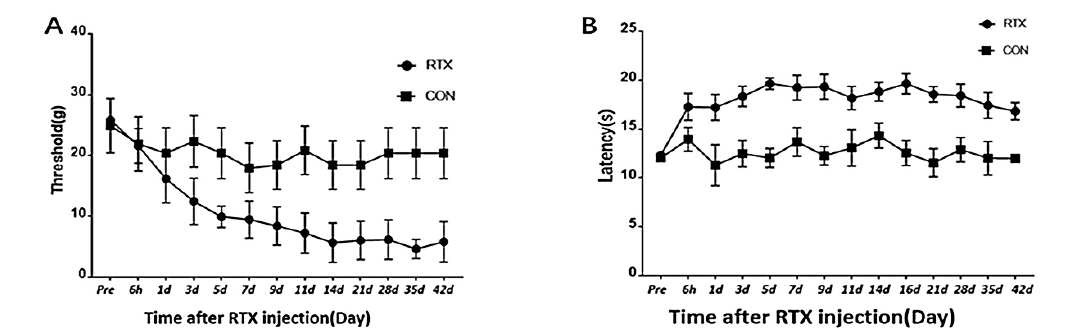
Figure 1. Mechanical pain threshold and thermal pain threshold changes in the PHN and CON groups. ( A ): Changes in the mechanical pain threshold of von Frey filaments in the PHN and CON groups. ( B ): Changes in the thermal pain threshold after thermal stimulation in the PHN and CON